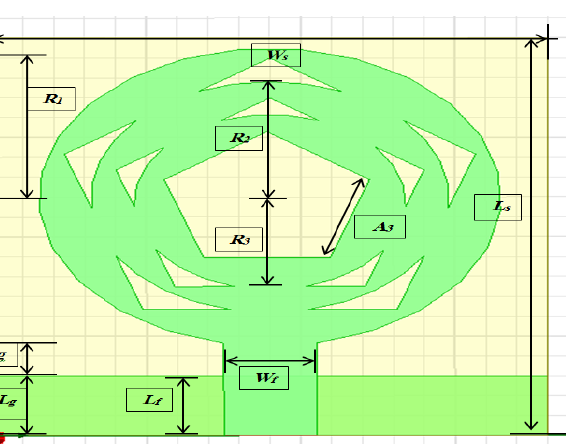
Figure 5 Simulated Return Loss S1.1 for Various Iterations